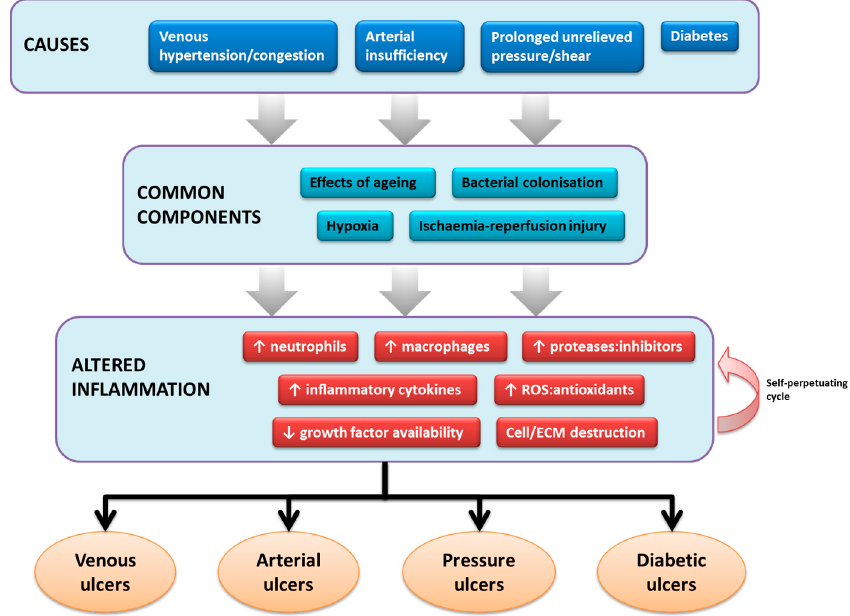
Figure 1. The role of inflammation in the pathophysiology of common chronic wounds. ROS = reactive oxygen species, ECM = extracellular matrix.